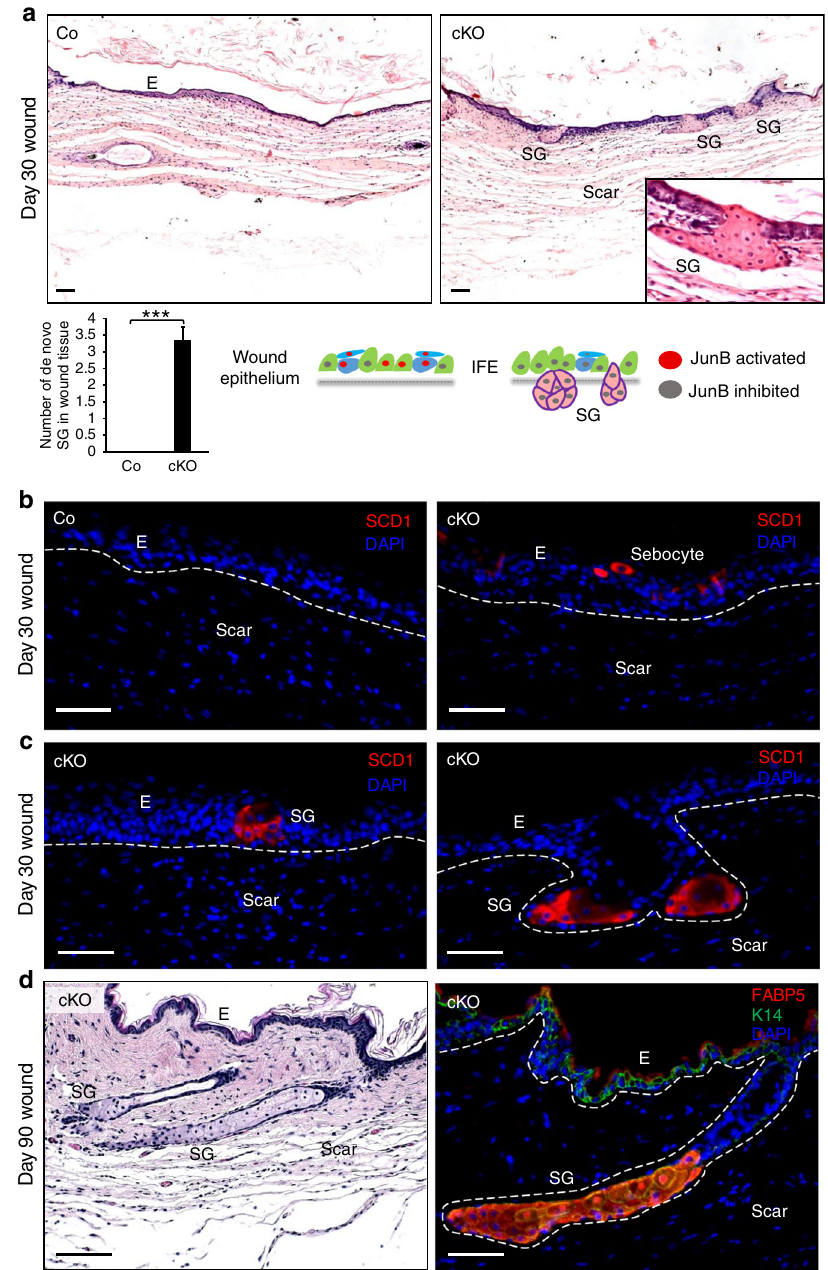
Fig. 4 De novo formation of sebaceous glands in JunB cKO wounds. a Representative H&E photomicrographs of 30 days old wound restoration tissue depicting ectopic sebaceous glands in JunB cKO mice. Inset showing magni fi ed view. E, epidermis; SG, sebaceous gland. Scale bars, 50 µ m. Quanti fi cation of de novo sebaceous gland numbers in 30 days old wounds. *** P < 0.001, t -test ( n = 3). Graphical sketch summarizes JunB-dependent suppression of epidermal progenitor differentiation towards sebocyte lineage (left bottom panel as opposed to lineage plasticity of epidermal progenitors towards sebocyte differentiation (right bottom panel). b , c Representative microphotographs with immunostaining of SCD1 (red), indicative of sebocyte differentiation, demonstrating different stages of de novo formation of sebaceous glands in 30 days old wounds in JunB cKO mice. Nuclei stained with DAPI in blue. d Representative photomicrographs displaying the formation of elongated sebaceous duct in 90-day-old wound epithelium in JunB cKO mice. Wound tissues were stained either with H & E or the sebaceous glands speci fi c marker FABP5 (red) and the basal layer speci fi c keratin K14 (green). Nuclei stained with DAPI in blue. Scale bars, 50 µ m. E, epidermis; SG, sebaceous Globally altered gene expression pro fi le in JunB cKO skin . To JunB cKO and wild type uninjured skin or skin harvested after wounding and hair plucking, respectively (Fig. 6a, b, Supple- comprehensively assess global gene expression changes under mentary Figure 8A and 8B). As expected, we observed a marked normal as well as stress conditions like wounding and hair increase in pro-in fl ammatory genes from JunB cKO wounds as plucking, dorsal skin from epidermal JunB cKO and wild type compared to wild type wounds. A signi fi cant upregulation in mice were subjected to transcriptome analyses. RNA-seq analyses pathways involved in cytokine and chemokine signaling as well as revealed considerable differences in gene expression between